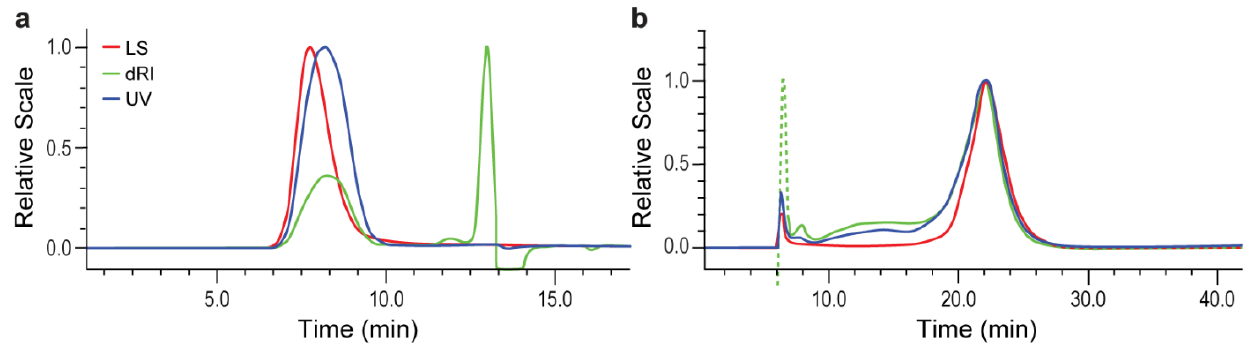
Figure 3. Chromatograms of a ST-1 MVC: ( a ) SEC-MALS; ( b ) AF4-MALS. (Dotted line in ( b ) repre- sented change of channel pressure after the focus step).